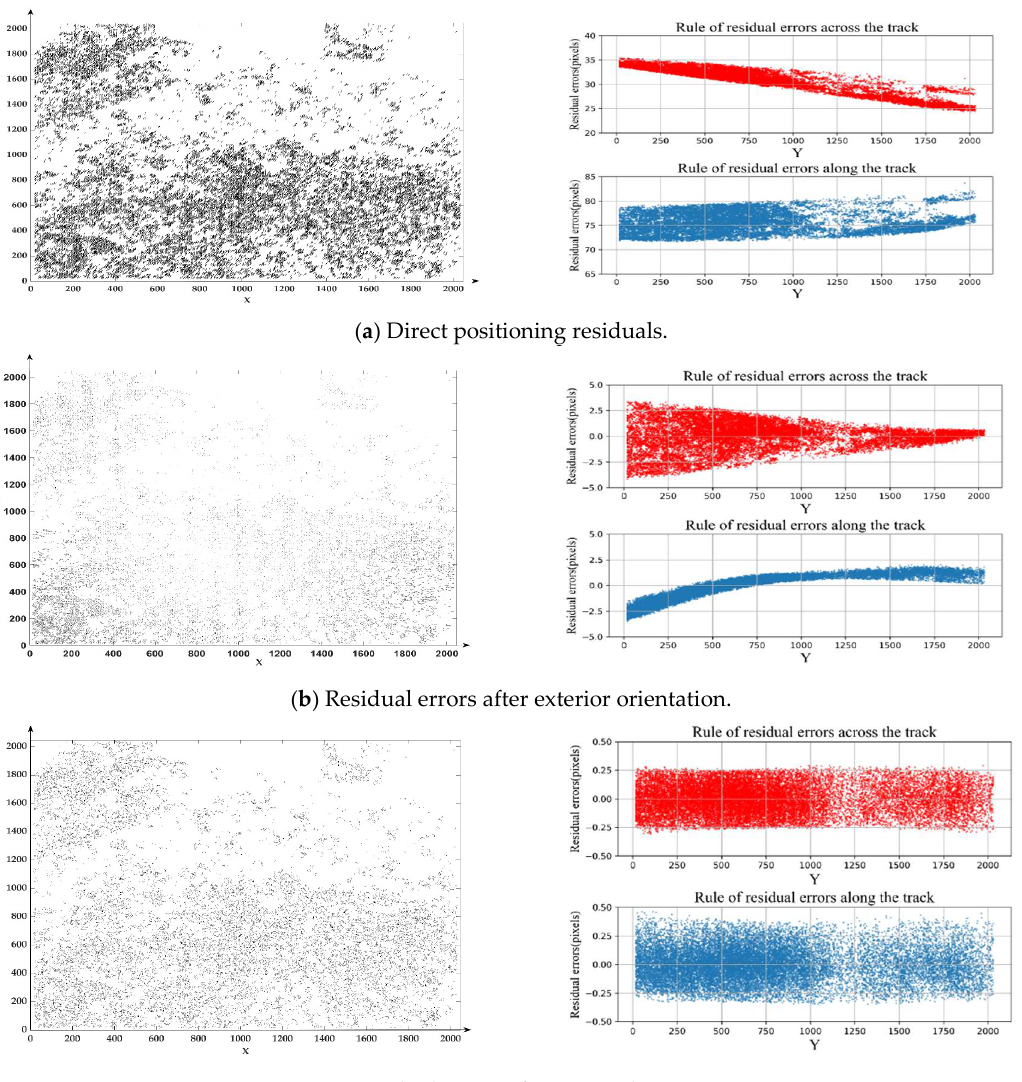
Figure 9. Residual errors law of calibration